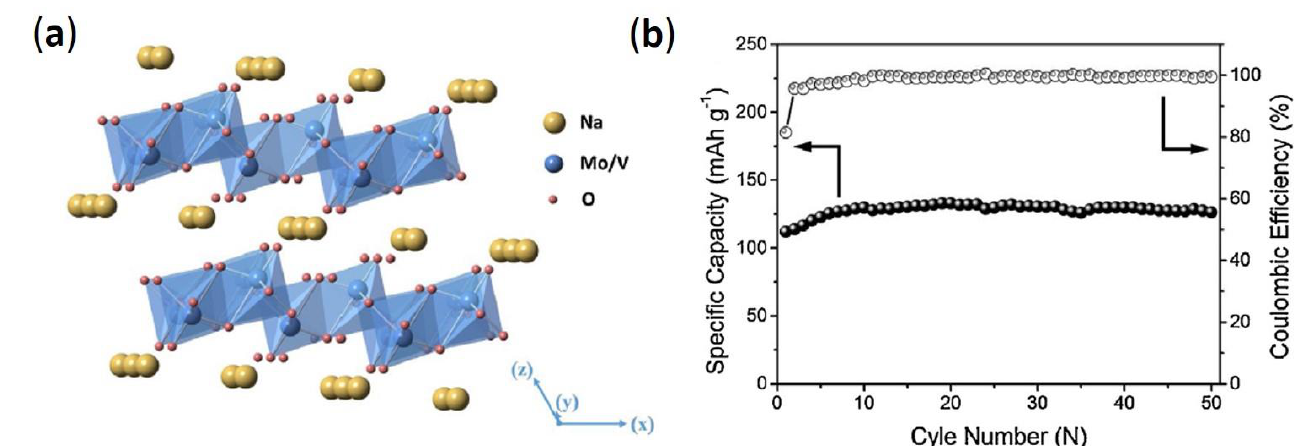
Figure 7. ( a ) Schematic structure and ( b ) battery performance for NaVMoO 6 [179]. In addition, a ferrocene-based MOF, iron (III) 1,1 (cid:48) -ferrocenedicarboxylate (Fe 2 (DFc) 3